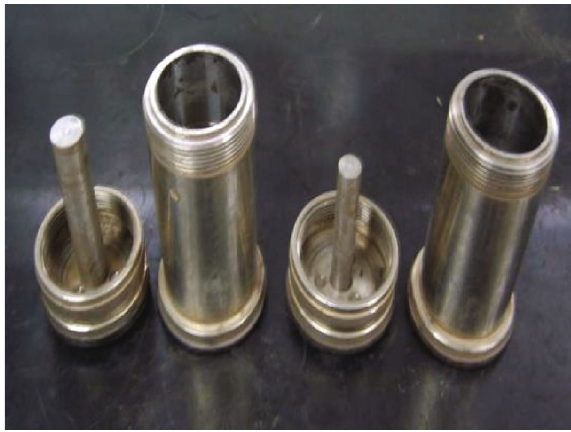
Figure 2: Picture of slake durability tester.